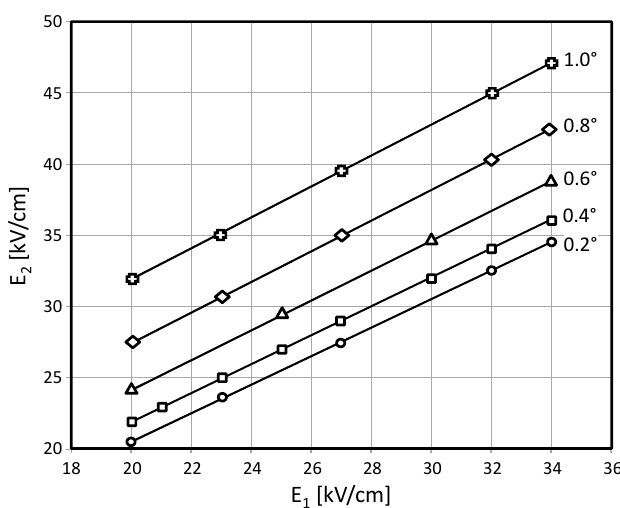
Figure 4. This figure reports the obtained values of the applied voltages that generated an EO interface for which a critical angle of the soliton is experimentally examined. The curves correspond to different input angles, whose values are reported on the right-hand side. All straight-line regression fits have a coefficient of determination R 2 = 1.